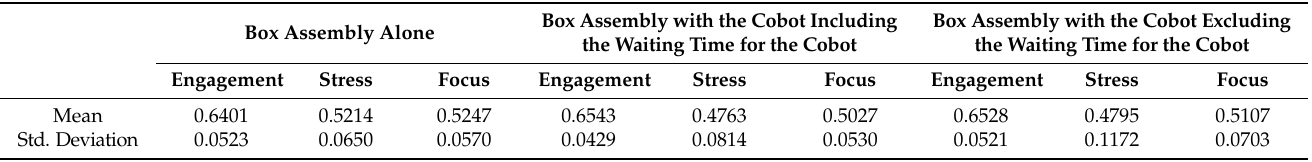
Table 2. Mean and std. deviation values for the human profiling data of the selected emotions (Stress, Engagement and